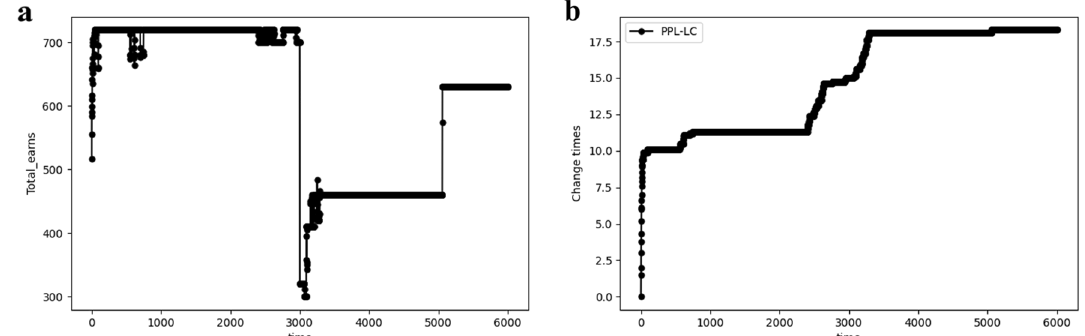
Figure 10. The performance of PPL-LC. ( a ) The relationship between transmitted information bits and time when distribution changes. ( b ) The relationship between the number of channel exchanges and the time when distribution changes.